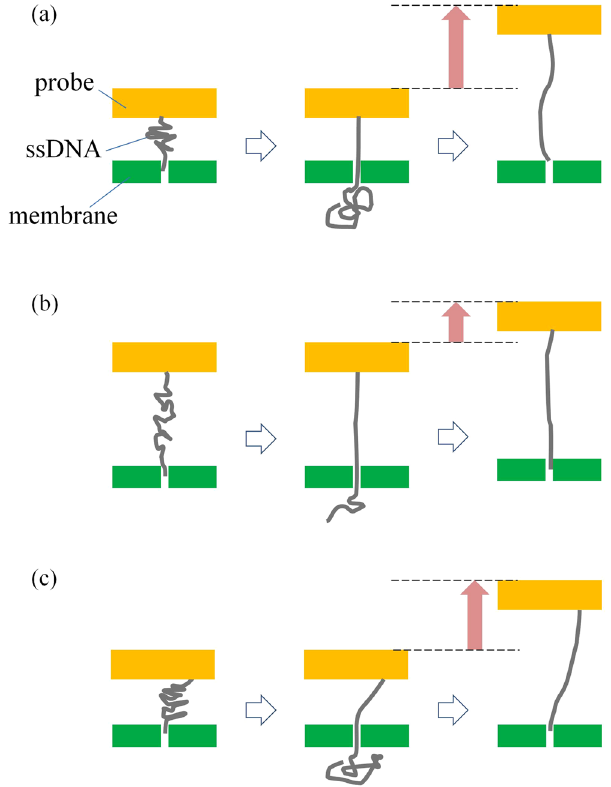
Figure 9. Different examples of how immobilized DNA might enter the nanopore. ( a ) An example of when a tightly folded DNA enters the nanopore and the DNA is subsequently pulled out. ( b ) An example of when a less-folded DNA enters the nanopore and the DNA is subsequently pulled out. ( c ) An example of the situation that occurs when the nanopore is not aligned to the point at which DNA is attached to the